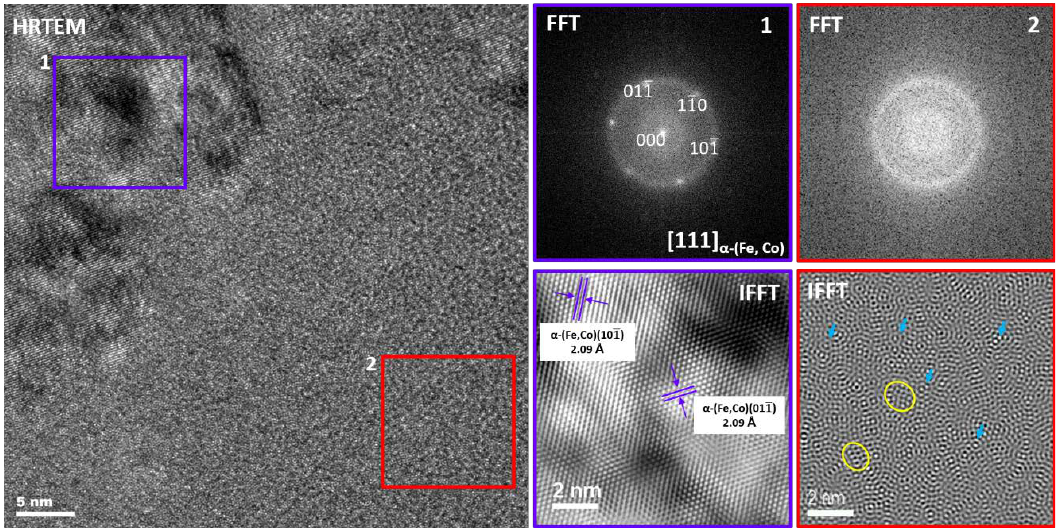
Figure 3. High-resolution transmission electron microscopy (HRTEM) image and fast Fourier transform (FFT), and an inverse fast Fourier transform (IFFT) taken from crystalline (1) as well as amorphous (2) regions of as-spun Fe 67 Co 20 B 13 ribbon.